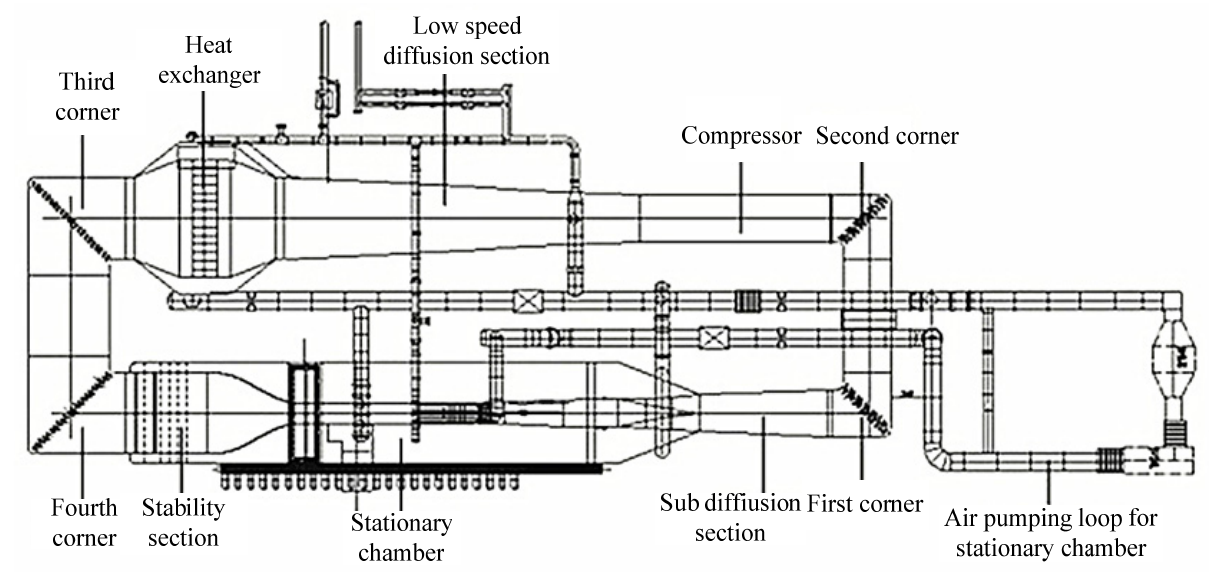
Figure 1. Structure of a wind tunnel system.